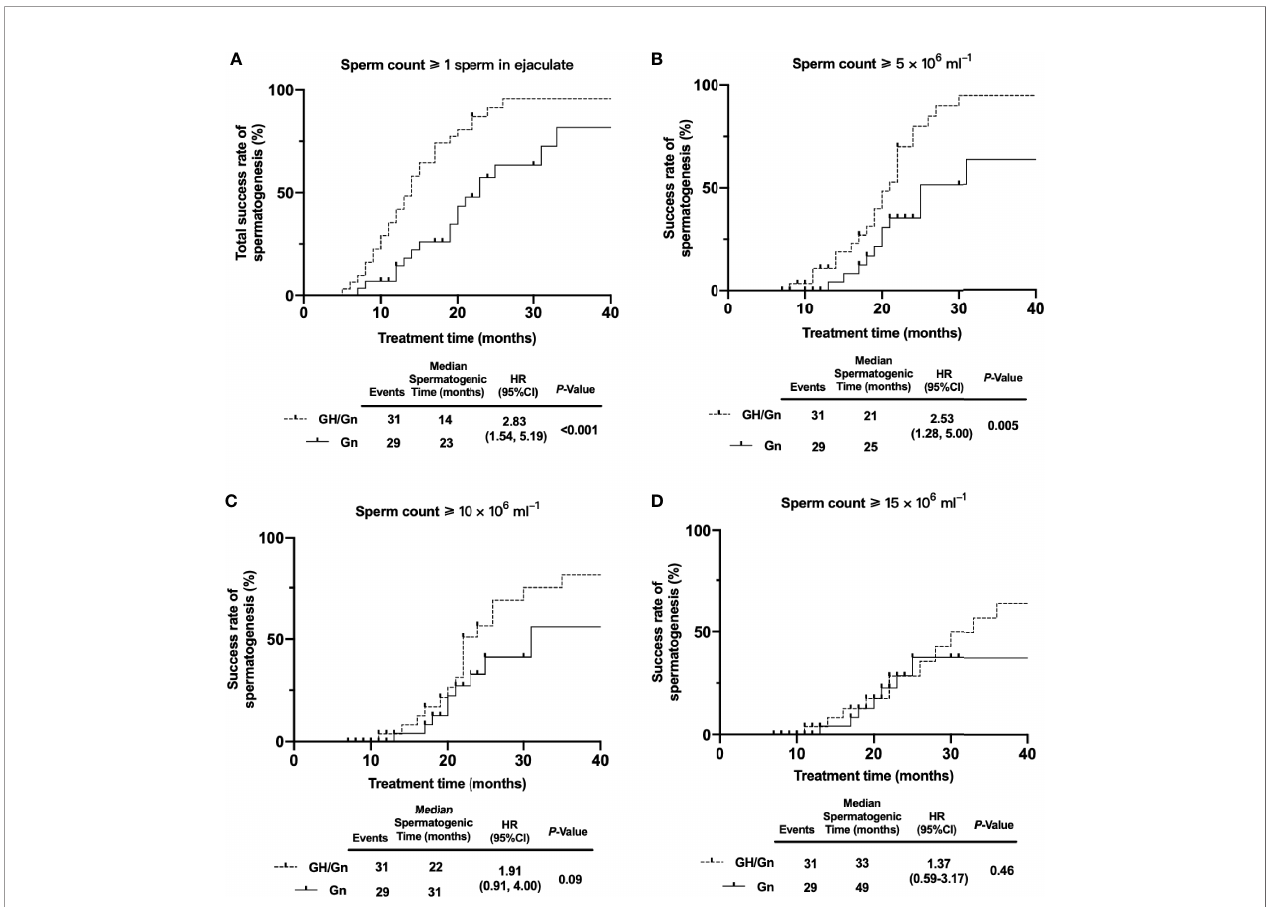
FIGURE 2 | A time-to-event analysis when sperm concentration ≥ 1, ≥ 5, ≥ 10, and ≥ 15 million/ml. (A) The median time to begin sperm production ( ≥ 1 sperm) in GH/Gn group is shorter than that in the Gn treatment group ( P < 0.001 ). (B) The median time of reaching a sperm threshold ≥ 5 × 10 6 ml − 1 in GH/Gn group is shorter than that in the Gn treatment group ( P = 0.005 ). (C) The median time of reaching a sperm threshold ≥ 10 × 10 6 ml − 1 is no statistically signi fi cant between the two groups ( P = 0.09 ). (D) The median time of reaching a sperm threshold ≥ 15 × 10 6 ml − 1 is no statistically signi fi cant between the two groups ( P = 0.46 ).